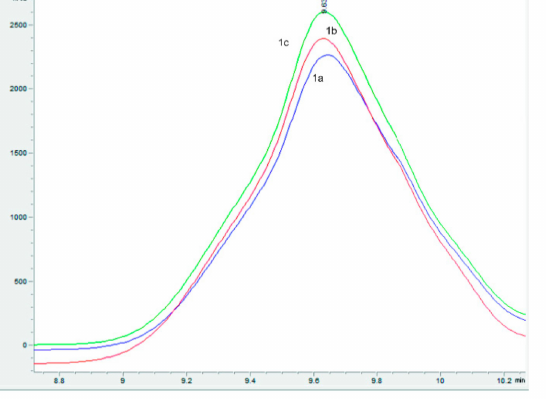
Figure 7. Chromatogram of high-performance exclusion chromatography of compounds 1a – c